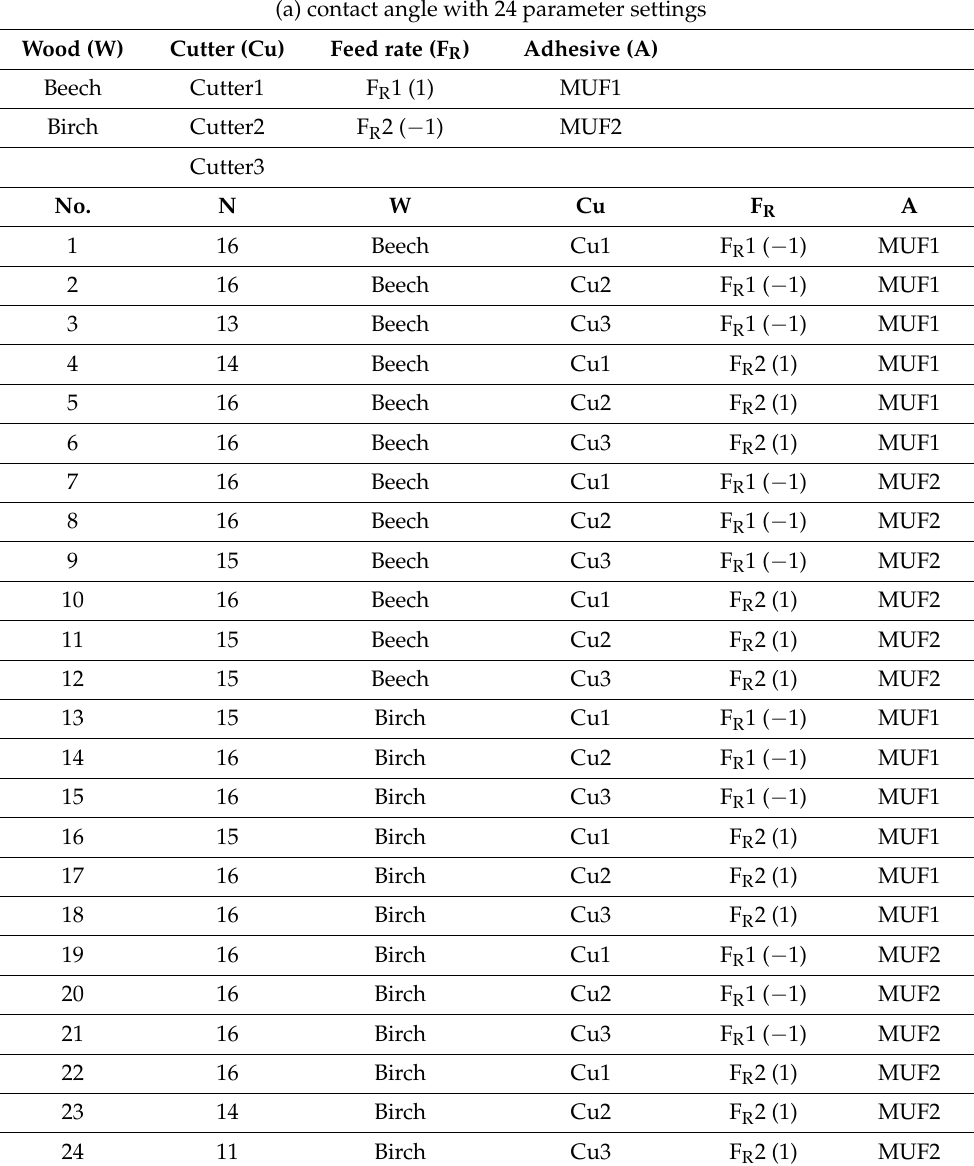
Table 2. Parameters, settings, and Full Factorial